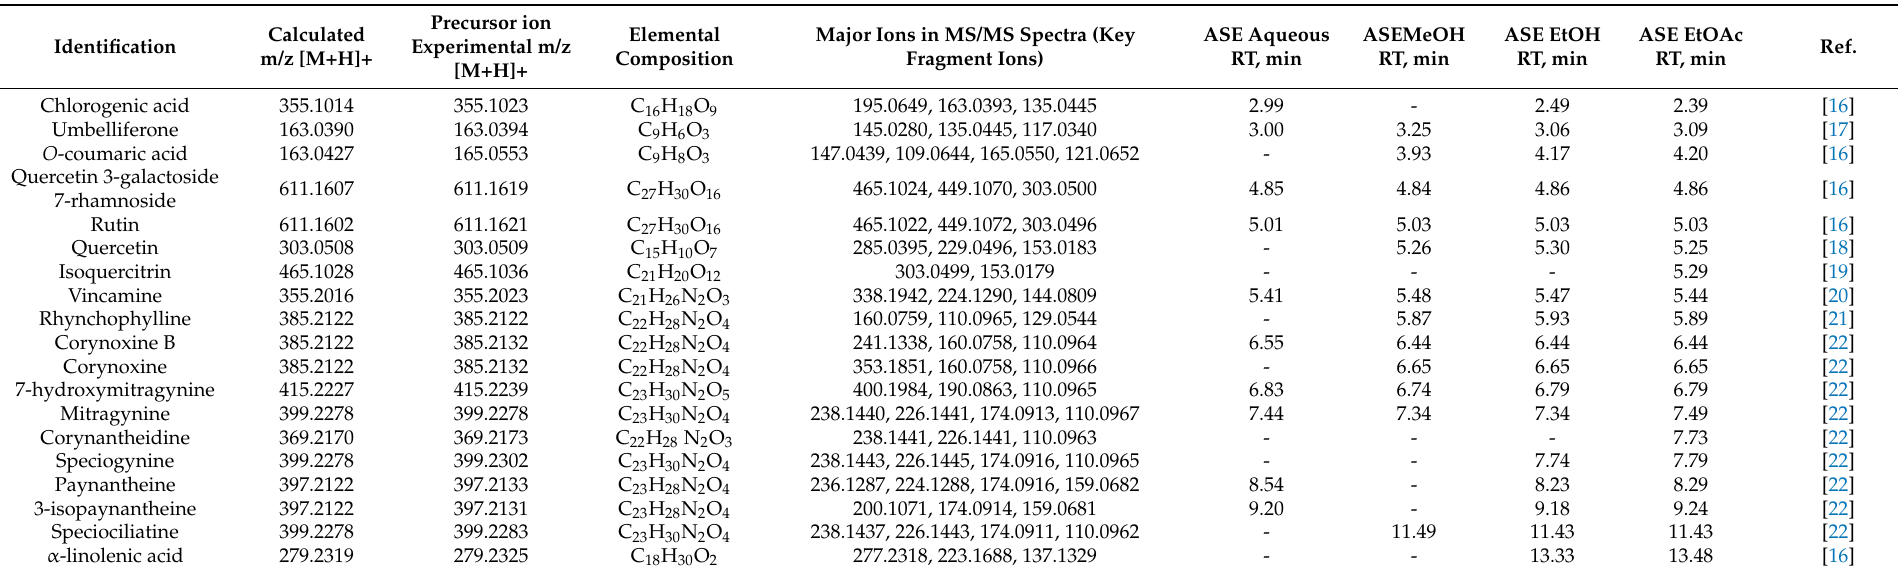
Table 6. MS/MS data of compounds identified tentatively in M. speciosa ASE aqueous, MeOH, EtOH, and EtOAc leaf extracts using UHPLC-ESI-QTOF-MS/MS.